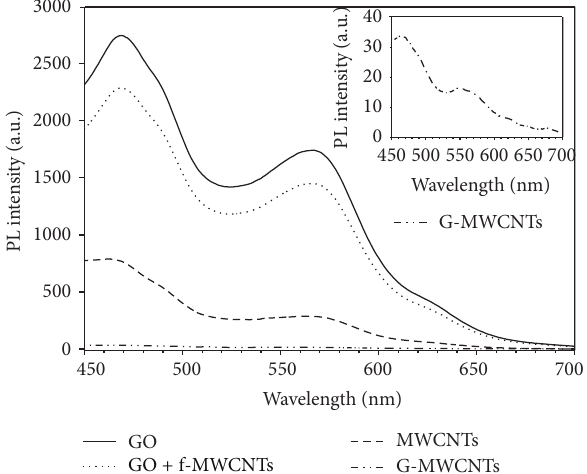
Figure 3: PL spectra of GO (solid line), GO + f-MWCNTs (dotted line), f-MWCNTs (dashed line), and G-MWCNTs (dotted-dashed line with inset depicting the drastic decrease in intensity). The excitation wavelength was 240